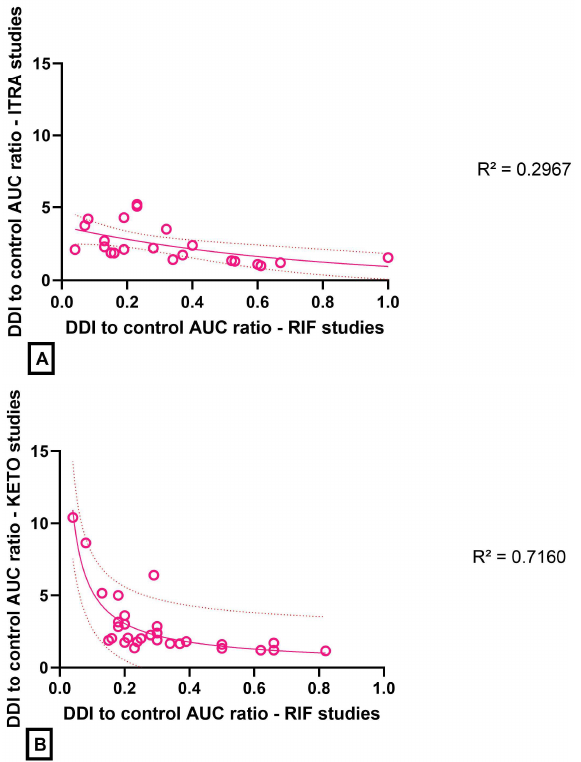
Figure 2. Magnitude of the DDI (estimated by the DDI-to-control AUC ratio) in inhibition DDI studies (with KETO or ITRA) as a function the magnitude of the DDI in induction DDI studies (RIF). ( A ): itraconazole DDI study versus rifampin DDI study. ( B ): ketoconazole DDI study versus rifampin DDI study. The coefficient of determination R 2 is indicated for each relationship; the 95% confidence interval is represented on each plot.